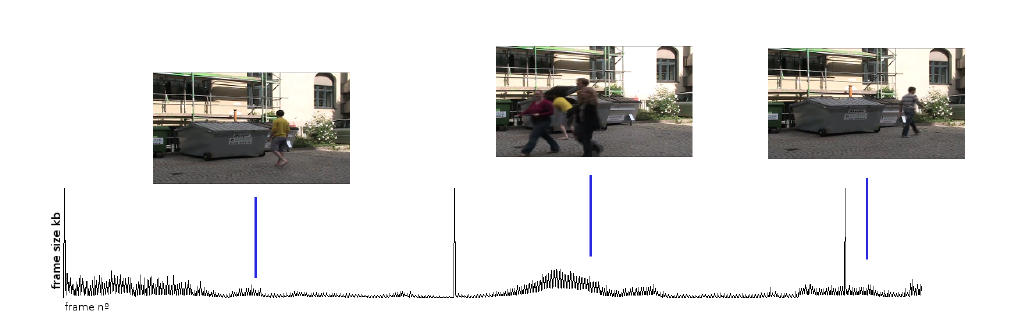
Figure 1. Variable bit-rate (VBR) signal from h264